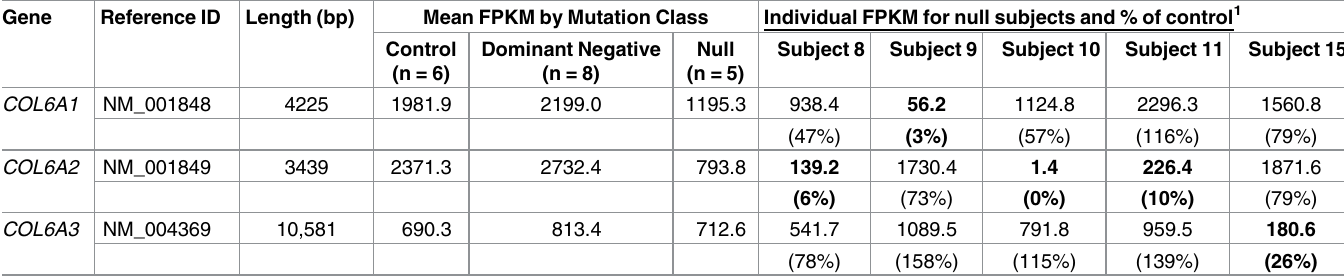
Table 2. Expression levels for COL6A1 , COL6A2 , and COL6A3 genes.